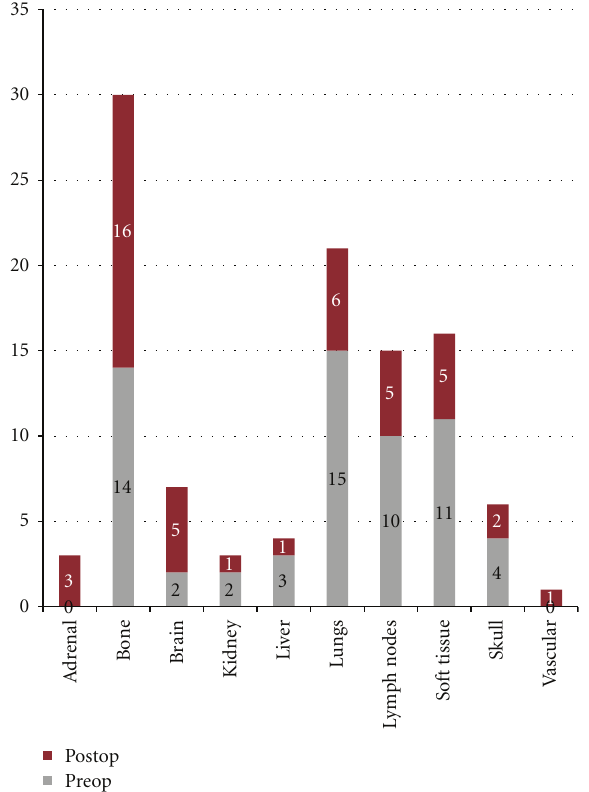
Figure 1: The distribution of other metastatic disease sites at the time of surgical intervention for osseous metastasis is shown in the lower bars. After surgery, the sites of subsequent metastases formation are shown in the upper bars. The most common site of metastatic disease prior to surgery was lung. Following surgery, bone was the most common site of new metastatic disease.